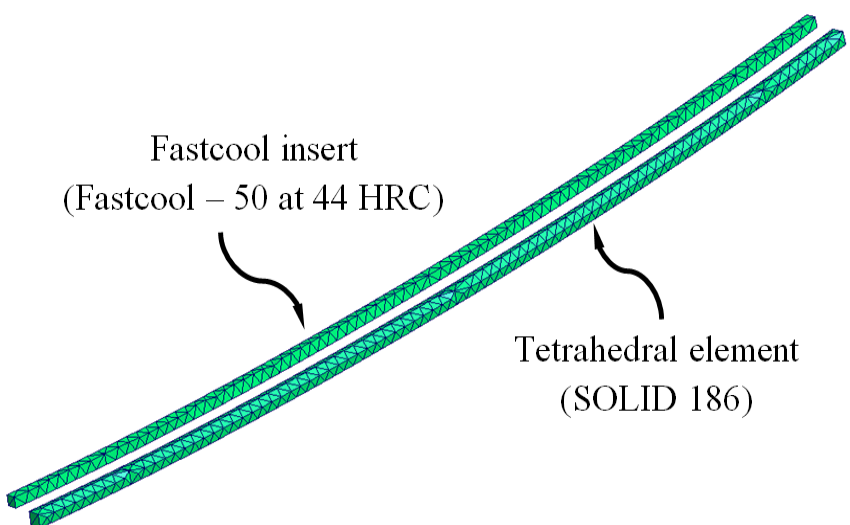
Figure 11. Fastcool insert meshes.